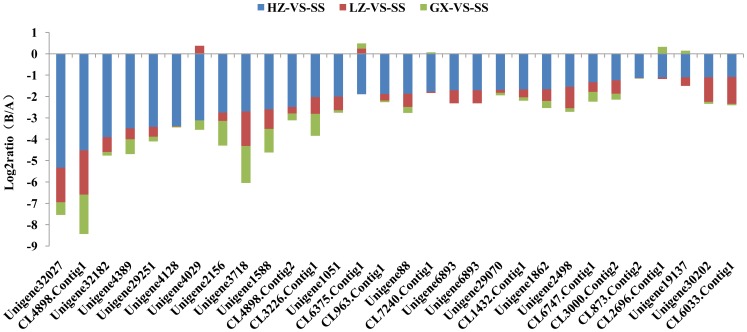
The expression trend and level of genes involved in the muscle control pathways of P. xylostella.
The muscle contraction pathways include vascular smooth muscle contraction and cardiac muscle contraction.